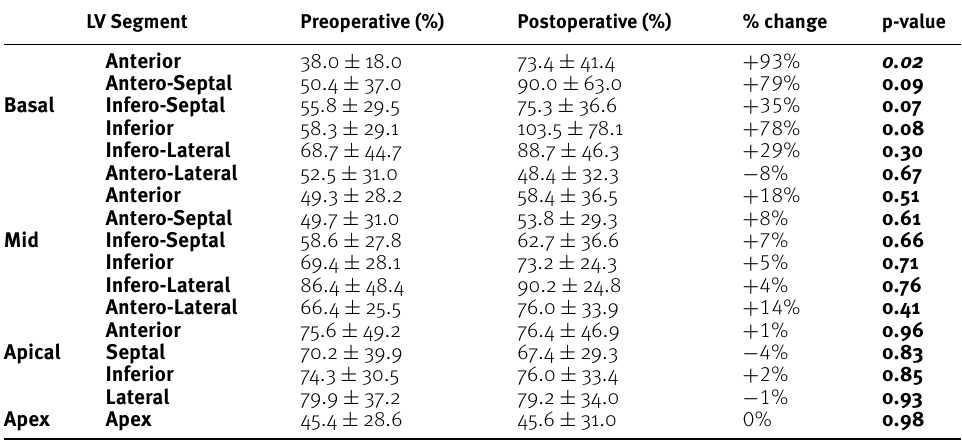
Table 3. Changes in regional LV wall thickening following tailored surgical myectomy for HCM.